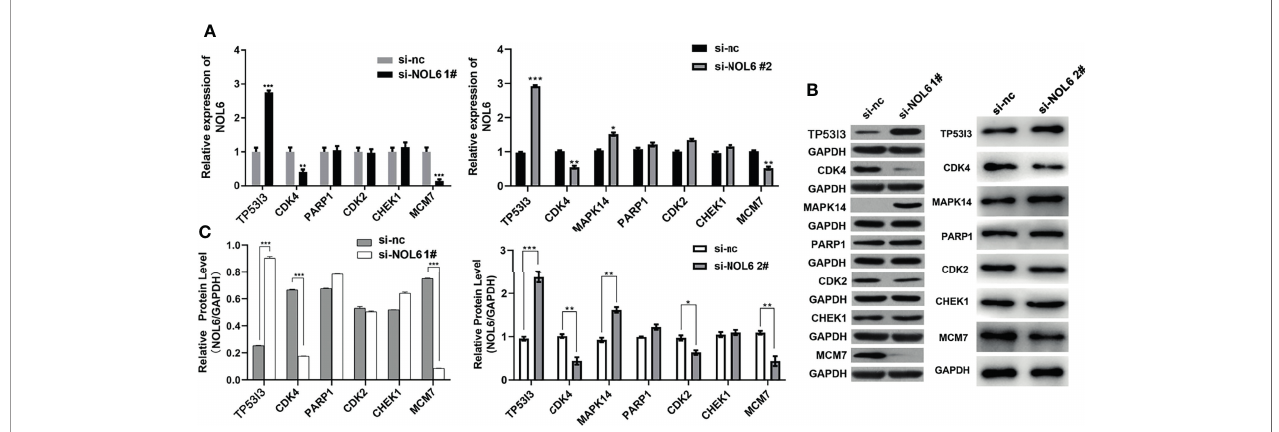
FIGURE 7 | Expression changes of downstream genes following NOL6 knockdown. (A) Effect of si-NOL6 on the gene expression of TP53I3, CDK4, PARP1, CDK2, CHEK1 and MCM7 in the AGS cells was detected by qRT-PCR. (B, C) Effect of si-NOL6 on the protein expression of TP53I3, CDK4, PARP1, CDK2, CHEK1 and MCM7 in the AGS cells was evaluated by western blot. (*p < 0.05, **p < 0.01, ***p < 0.001 v.s. si-nc).